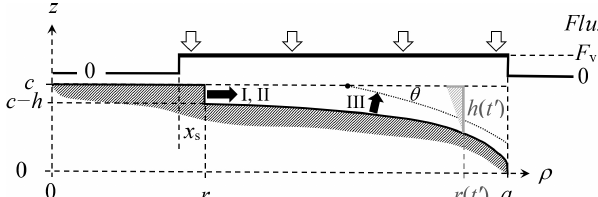
Figure A1. Facet spreading models. Dark shading shows the surface region of one quadrant of the crystal cross section at a given time t . The flux calculation treats the crystal as a thin disk of radius a with flux F v uniform between r − x s and a ; zero elsewhere (upper curve). The face edge front at radial position r has height h for mechanisms I and II. At a later time t (cid:48) , the value of h is larger (light shading) due to the advancement to r(t (cid:48) ) , making a larger distance between the rough surface and basal surface plane. For III, the edge front is instead assumed to lie at the intersection of the laterally growing face at c (dashed line) and the dotted curve, intersecting with angle θ